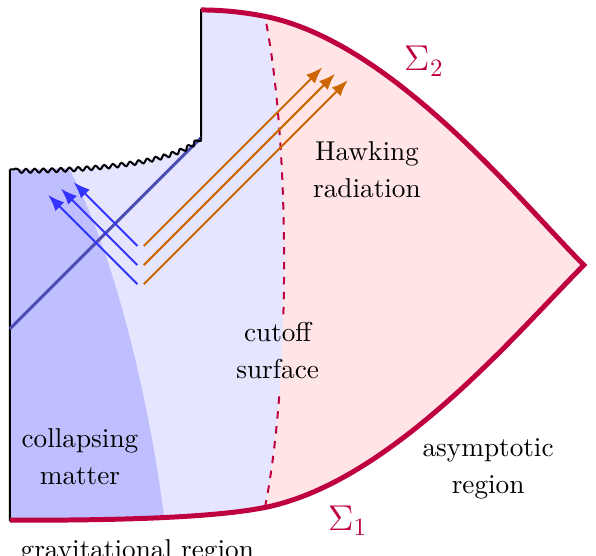
Figure 1. Spacetime is divided into asymptotic and gravitational regions, joined by a cutoff surface. Initially, the system is set up with a matter configuration that collapses to form a black hole. Then, the black hole evaporates, and all of the Hawking radiation is collected by the asymptotic region. (Note that we will continue to use this color scheme, in which the asymptotic region is red and the gravitational region is blue, throughout the